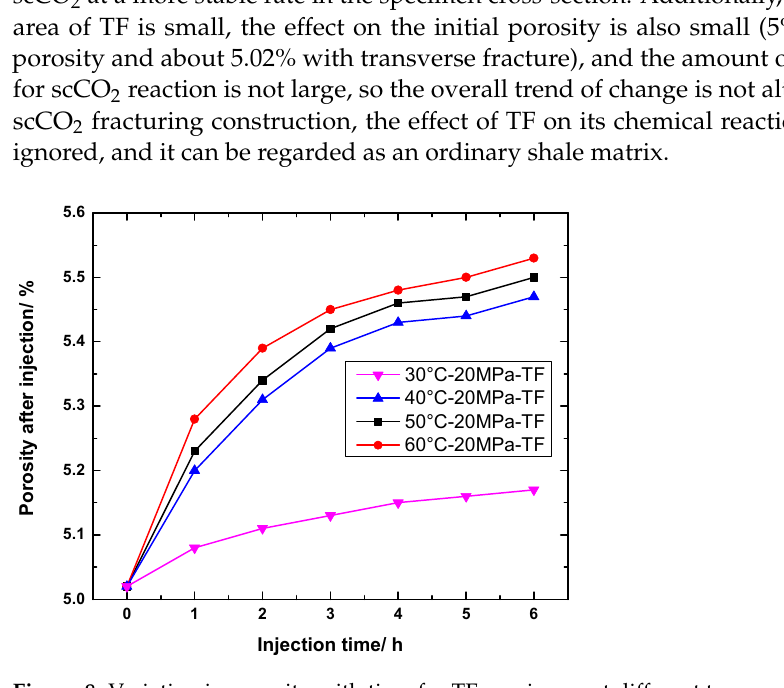
Figure 7. Variation in porosity with time for AF specimens at different temperatures under the same pressure of 20 MPa.